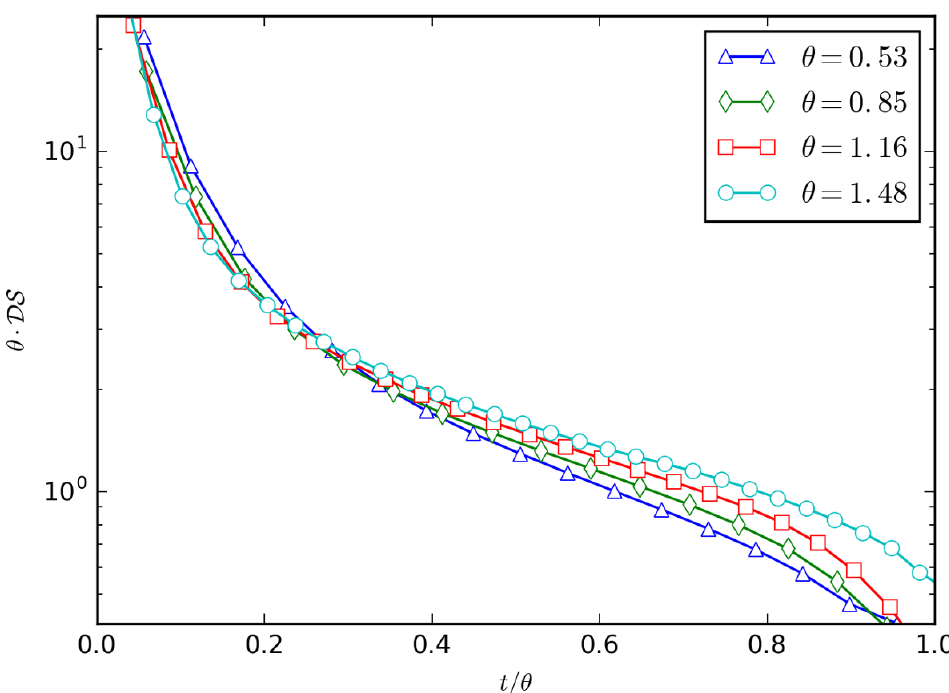
Figure 4 . Scaled logarithmic derivative of entanglement entropy following a mass quench as a function of time in units of the expected saturation time; for various polar cap sizes. All curves are for the theory on the commutative sphere with N = 150 and a pre-quench mass of (cid:22) = 10. We can see the dependence of the global behaviour F (cid:6) ( t ) on the size of the polar cap (cid:6) from the fact that the curves appear (cid:13)atter as the angular size increases. Note that this e(cid:11)ect becomes more pronounced as the time approaches the saturation